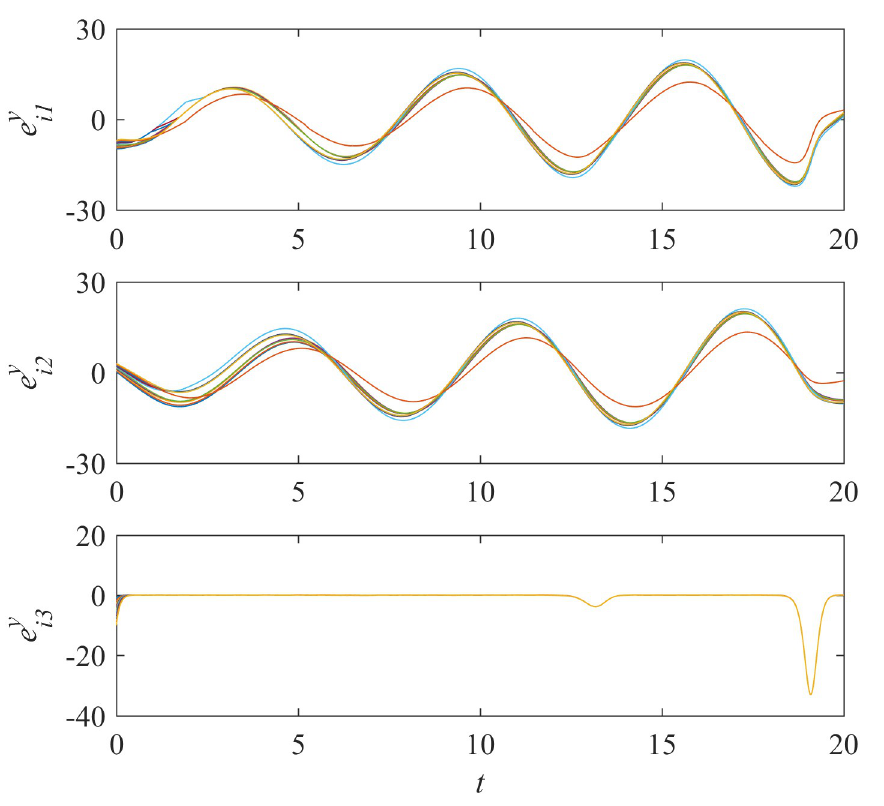
Fig 6. States of error system between the nodes and the isolate node in sub-network Y (Eq (2)).